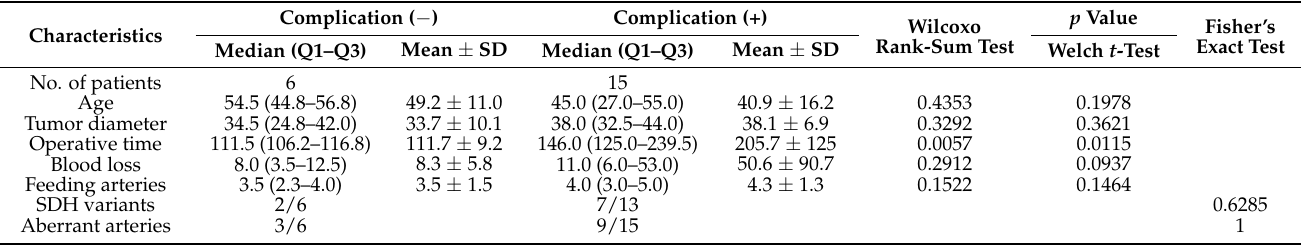
Table 2. Analyses of the relationship between clinical factors and complications of surgery. Characteristics